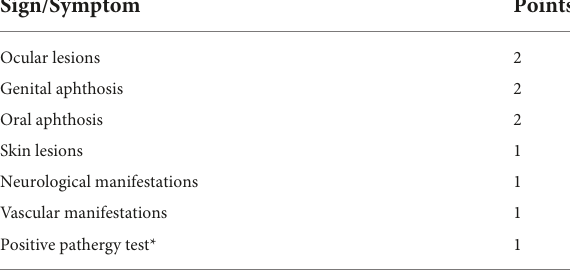
TABLE 1 Diagnostic criteria for Behçet’s disease (BD) according to the International Team for the Revision of the International Criteria for Behçet’s Disease (ITR-ICBD)